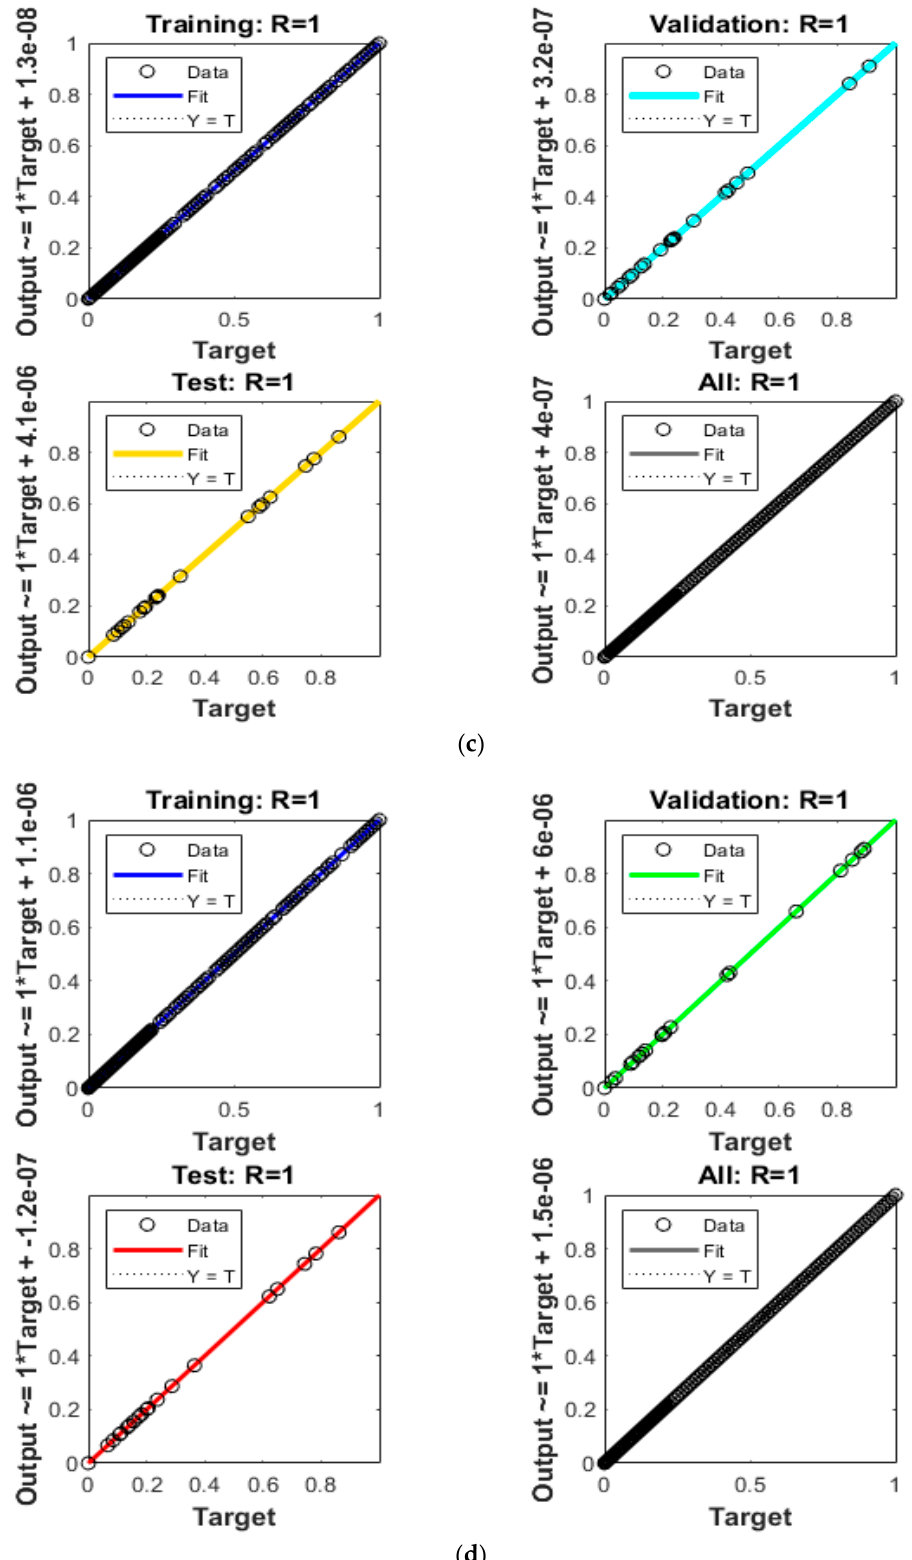
Figure 7. ( a – d ) ANNLMB outcome regression illustration of different scenarios. ( a ) ANNLMB outcome regression illustration of scenario 1; ( b ) ANNLMB outcome regression illustration of scenario 2; ( c ) ANNLMB outcome regression illustration of scenario 3; ( d ) ANNLMB outcome regression illustration of scenario 4.